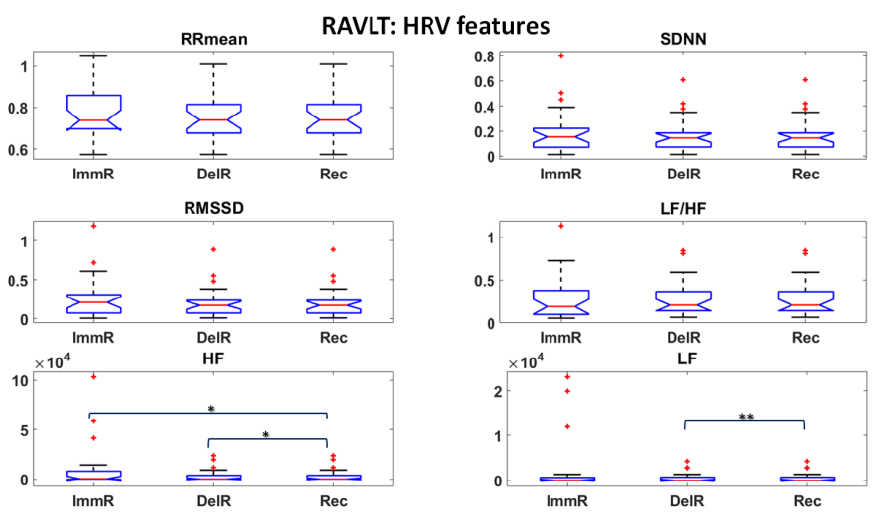
Figure 10. Thermal features relative to Glabella ROI extracted during RAVLT (* p < 0.05; ** p < 0.01). Outliers are represented with red crosses. The titles of the single plots refer to abbreviations of features described in Section 3.3.